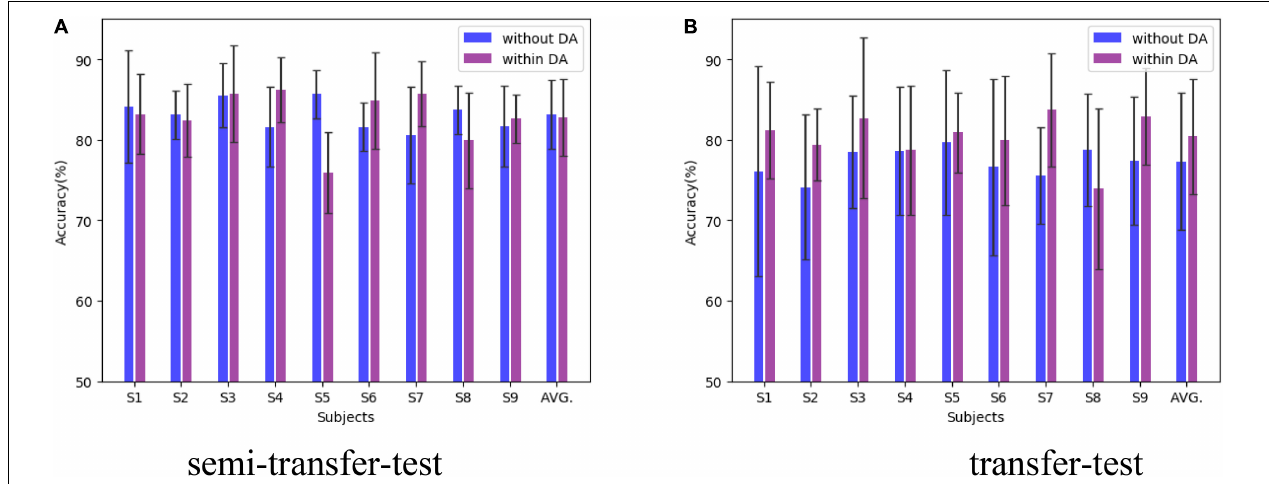
FIGURE 5 | Comparison of transfer capacity among subjects in D2. The black line upper and lower indicate the maximum and minimum deviation value.